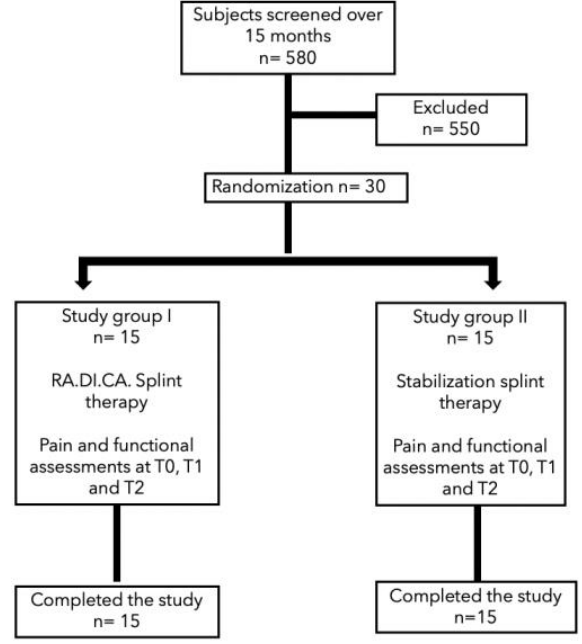
Figure 3. CONSORT criteria.